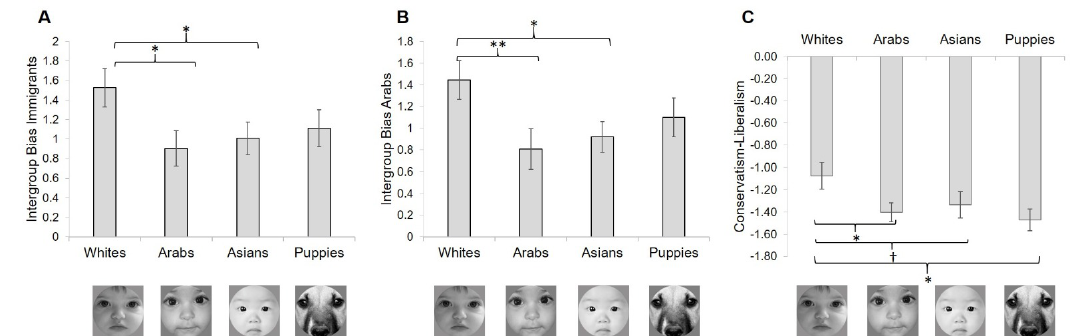
Figure 2. Effects of the type of face viewed on: ( A ) Perceived threat from undocumented immigrants (relative to one’s ingroup), ( B ) perceived threat from Arabs (relative to one’s ingroup), and ( C ) support for conservative (relative to liberal) values. Note: Values for conservatism (relative to liberalism) are negative given that the sample overall endorsed stronger liberal values than conservative ones ( † p < 0.10, * p < 0.05, ** p <